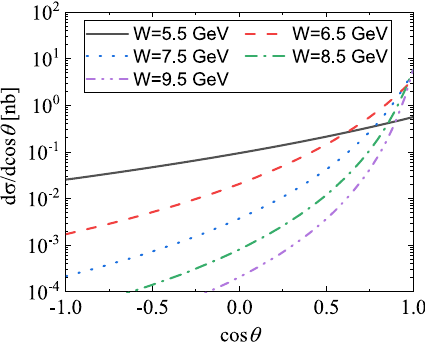
Fig. 3 The differential cross section d σ/ dcos θ of the X 0 production in K + p collisions at different center-of-mass energies with α = 1 . 5